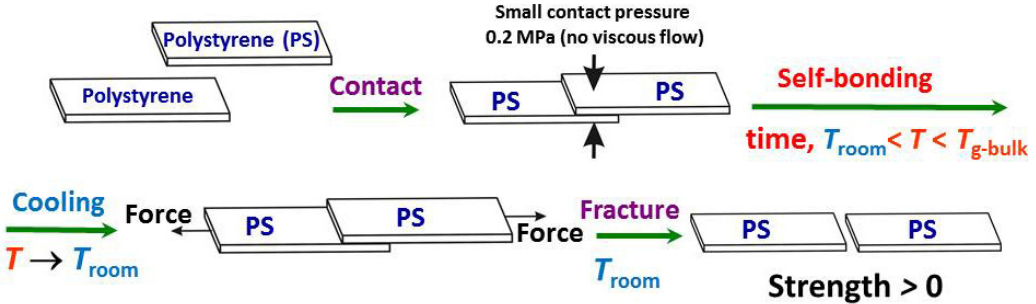
Figure 1. Scheme of the experimental procedures used in this work.